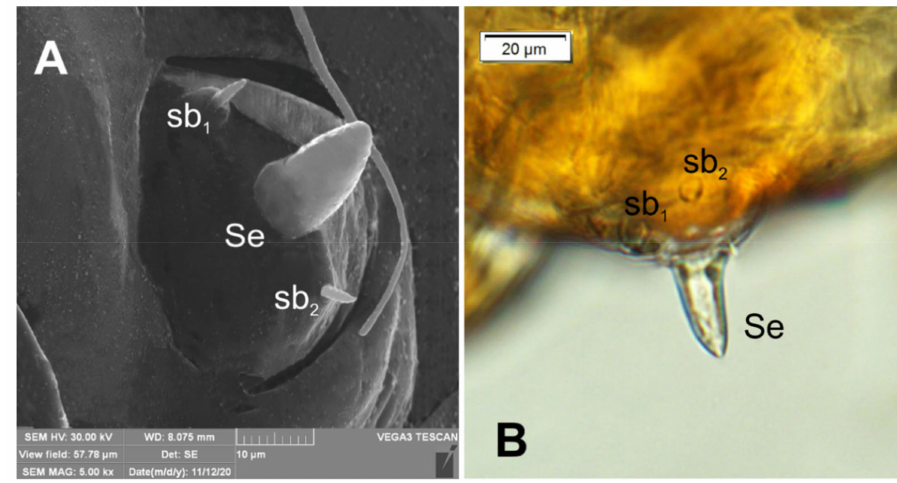
Figure 5. Lachnaeus crinitus mature larva, antenna. ( A )—antenna SEM photo; ( B )—antenna photo; (sa—sensillum ampul- laceum, sb—sensillum basiconicum, Se—sensorium).